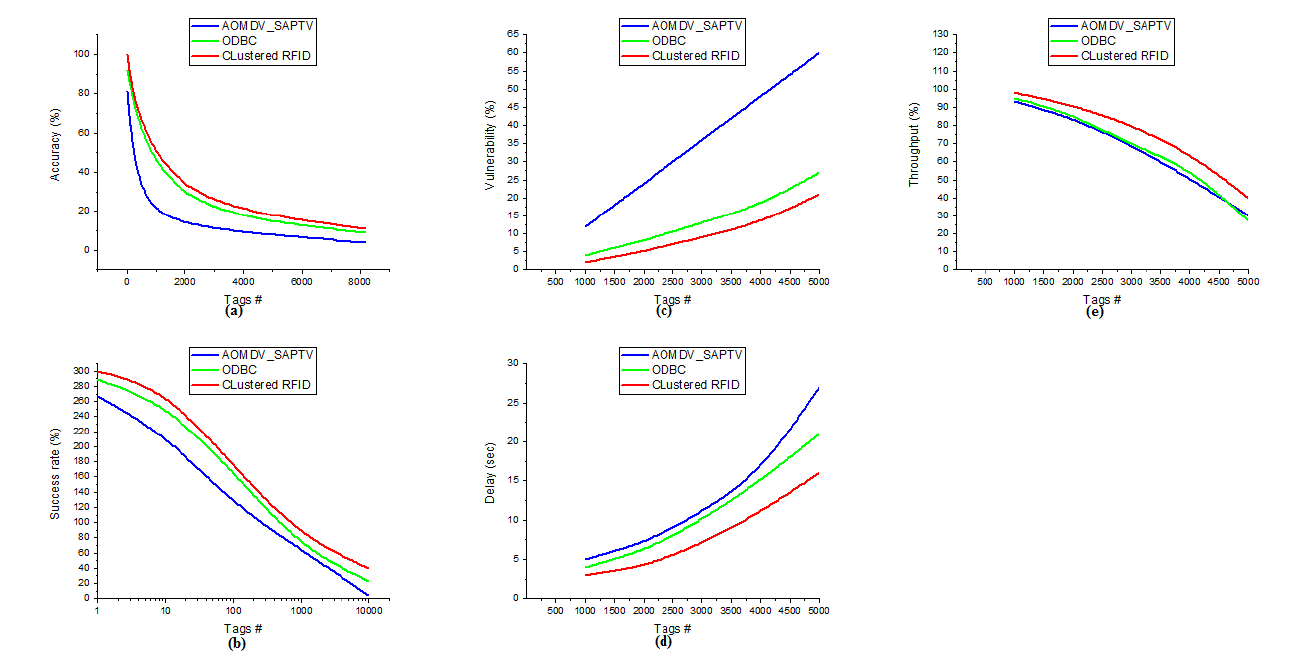
Figure 5. Comparison between AOMDV_SAPTV, ODBC with Clustered RFID.